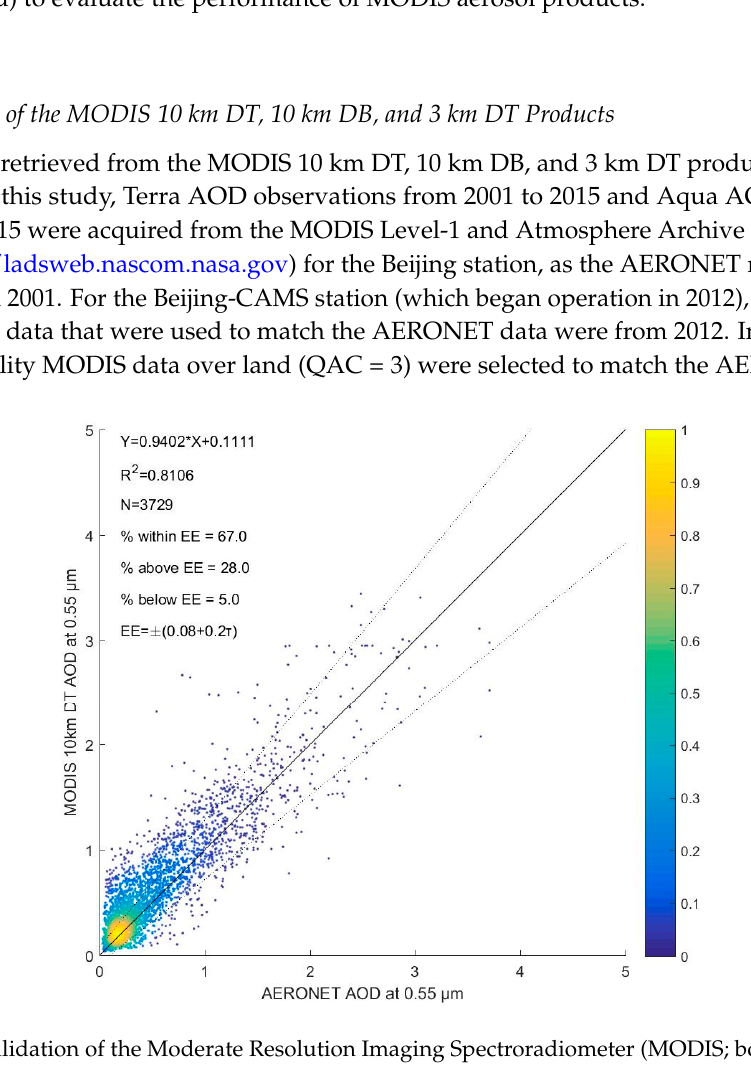
Figure 3. Validation of the MODIS (both Terra and Aqua) 10 km Deep Blue (DB) AOD against AERONET measurements at the Beijing station, and Beijing-CAMS station.